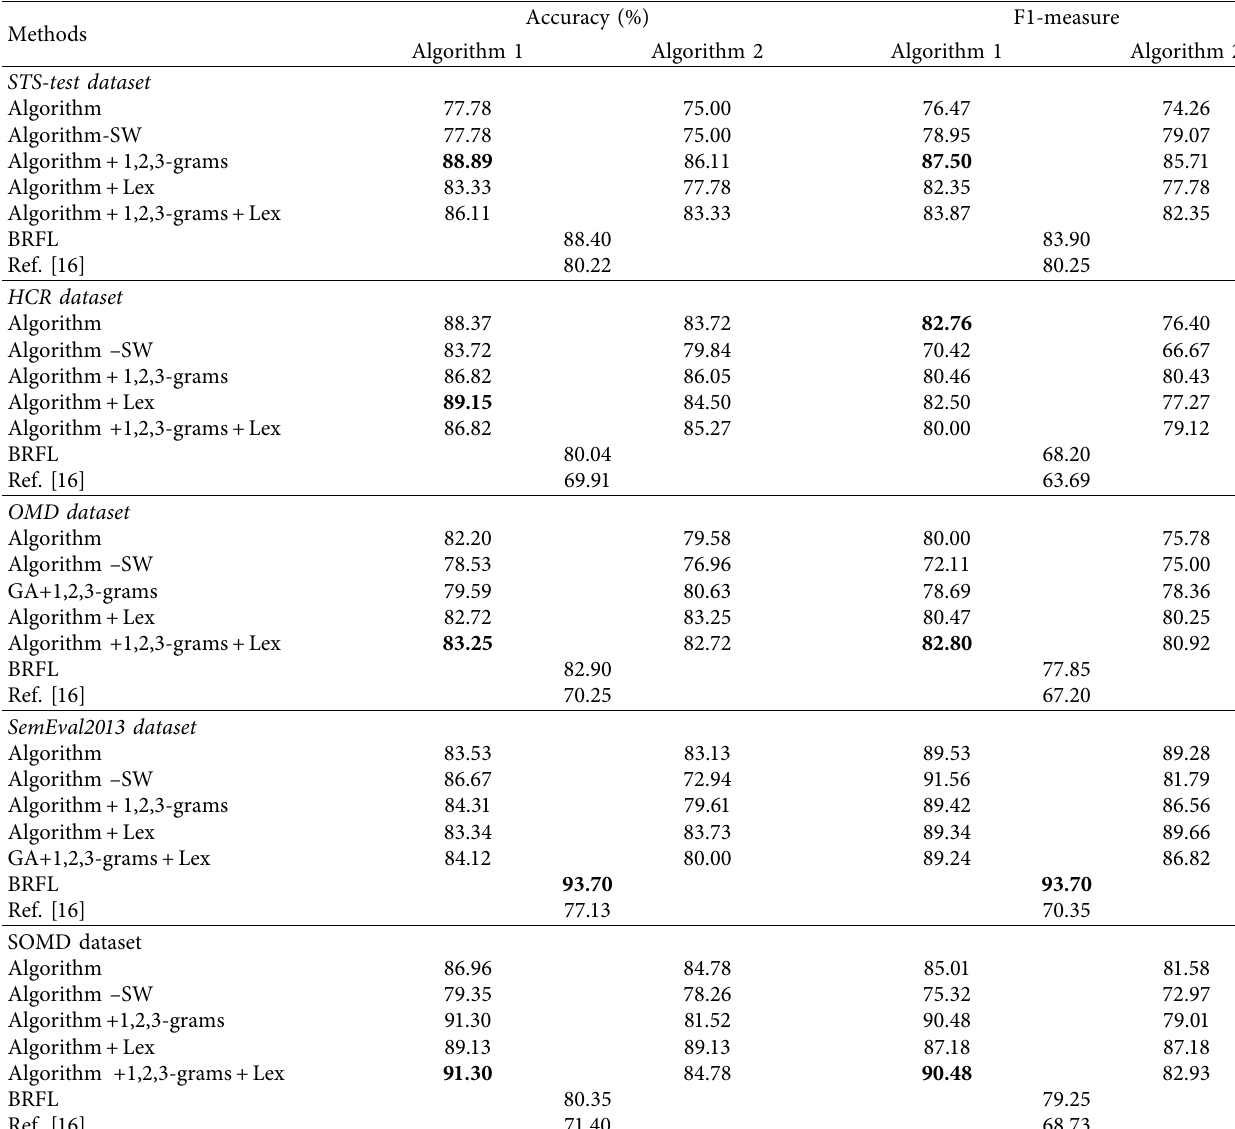
Table 4: Comparison of accuracy and F1-measure (the bold values represent the best values).